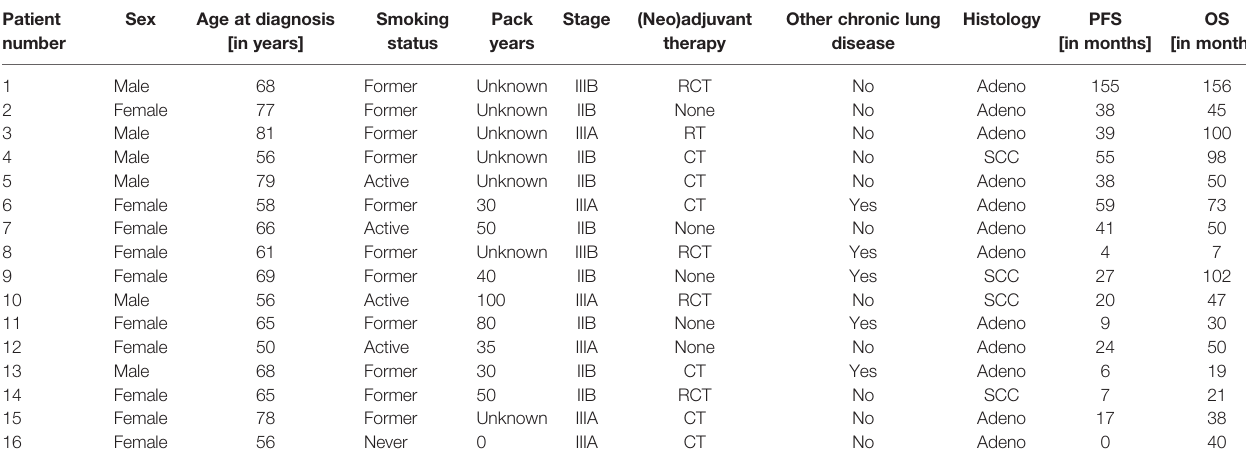
TABLE 1 | Overview of clinical features of the 16 patients included in this study. Patient